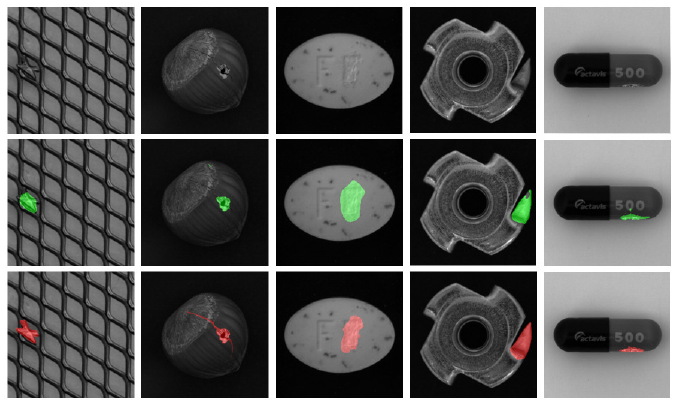
Figure 1. Examples of the objects and their segmentation maps. ( Top row ) Original input. ( Middle row ) Our method’s results. ( Last row ) Segmentation ground